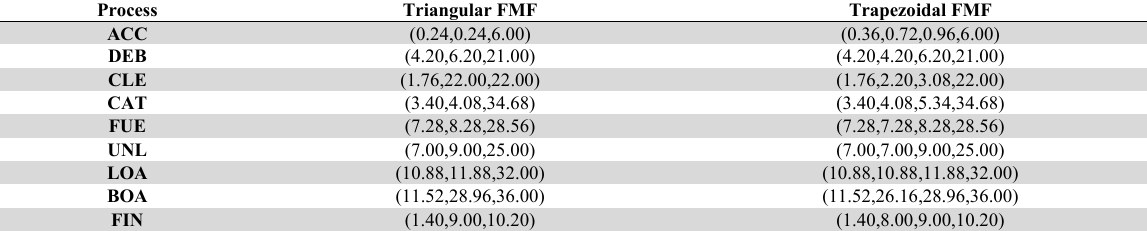
Fig. 5. Result of Goodness-of-Fit of K-S test for each Process Duration The optimal combinations for the parameters of each fuzzy membership function are shown in Table 2. The K-S test indi- cated that each fuzzy membership function was stable between 0.08 and 0.09. Parameter combinations of FMF for each